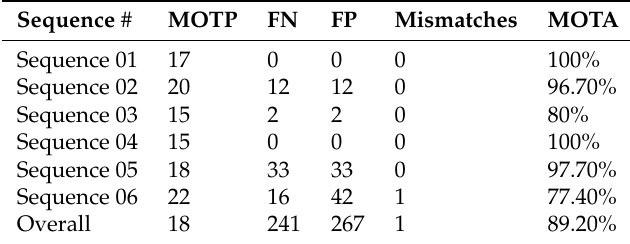
Table 2. Results for the Clear-multiple object tracking (MOT) evaluation